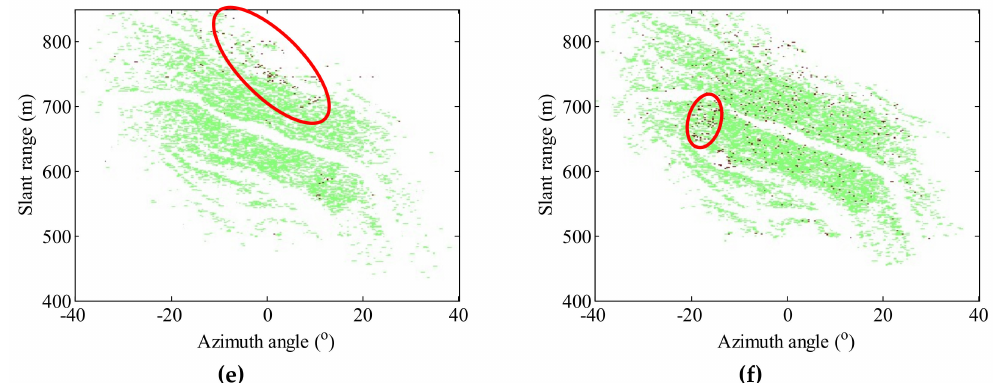
Figure 12. Phase deviation maps of ( a ) Group A and ( b ) Group B. Deviation scatter diagrams of ( c ) Group A and ( d ) Group B. Analysis results of the noise-dominant PSs (NPSs) of ( e ) Group A and ( f ) Group B, where red pixels denote the NPSs and green ones denote other PSs.